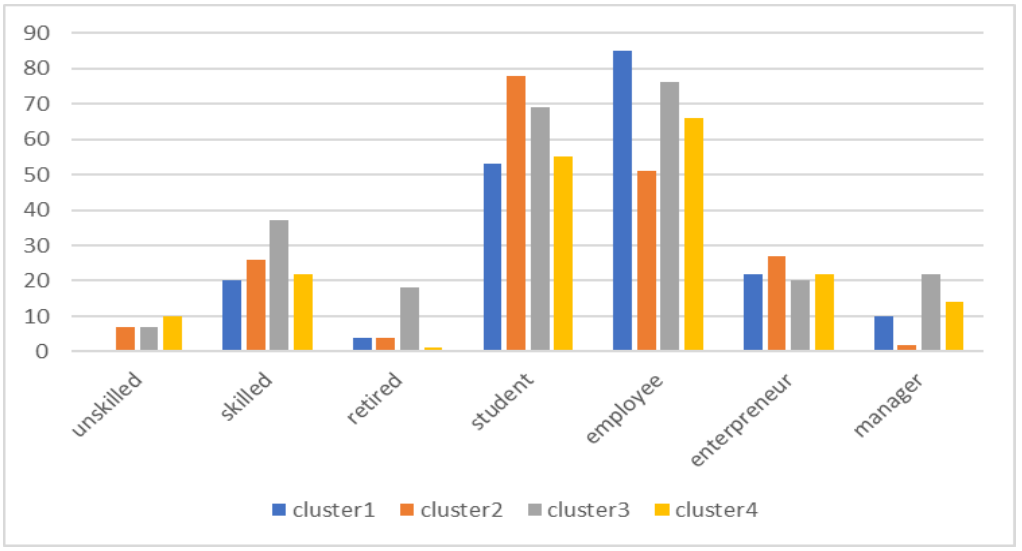
Figure 5. Distribution of respondents by occupation.